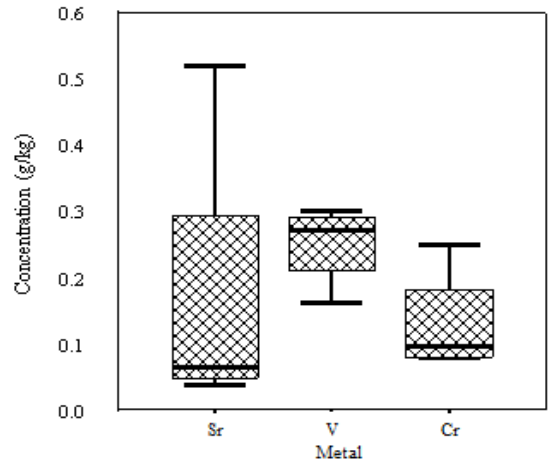
Figure 2. Statistics of Sr, V and Cr content in